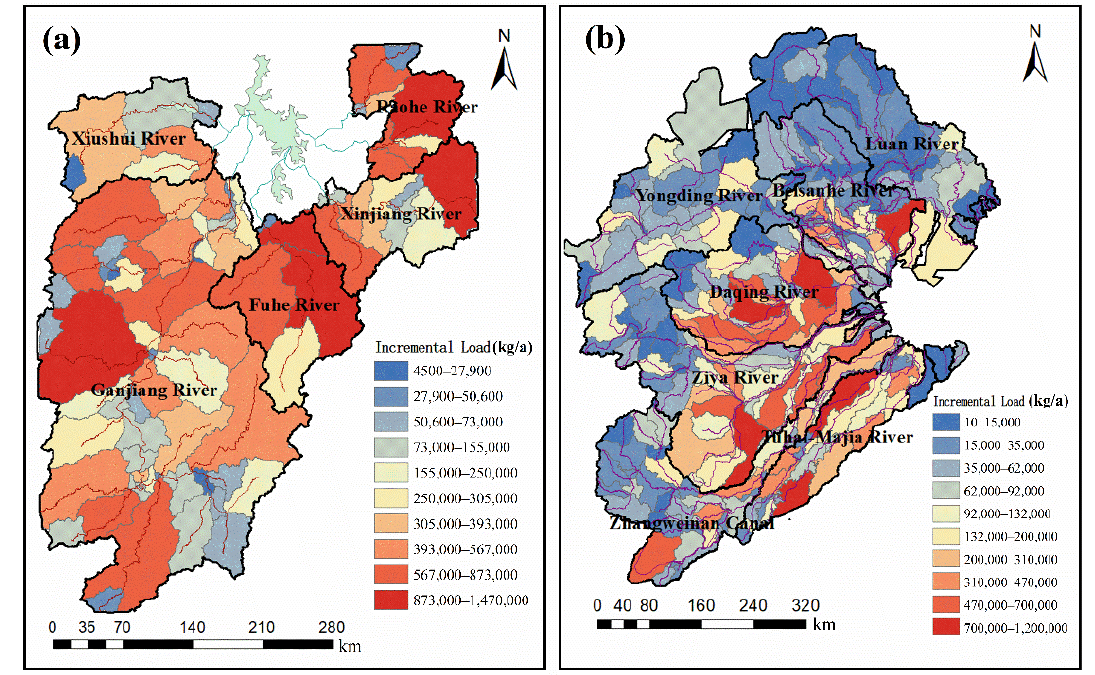
Figure 7. Incremental loads (kg/a) of NH 4+ -N in ( a ) PLB and ( b ) HRB. Table 5. Nutrient sources’ fluxes and fractions in main rivers in PLB.